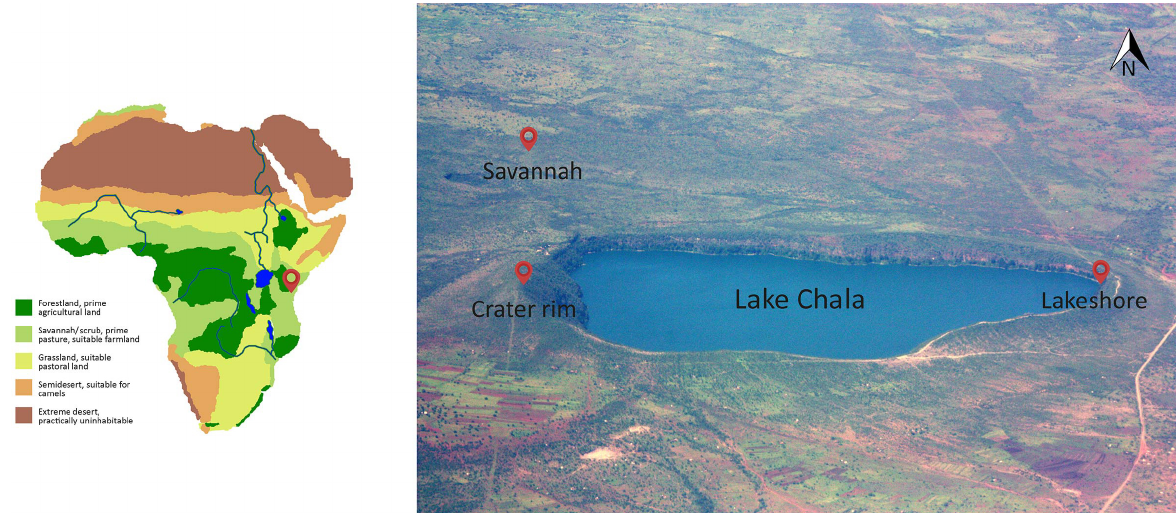
Figure 1. Lake Chala, situated in equatorial East Africa, on a continent-scale vegetation map (left) and with the different sampled habi- tats (right). Sampling sites in savannah, at the lakeshore and on the crater rim are indicated by red dots. Adapted from Wikimedia Com- mons